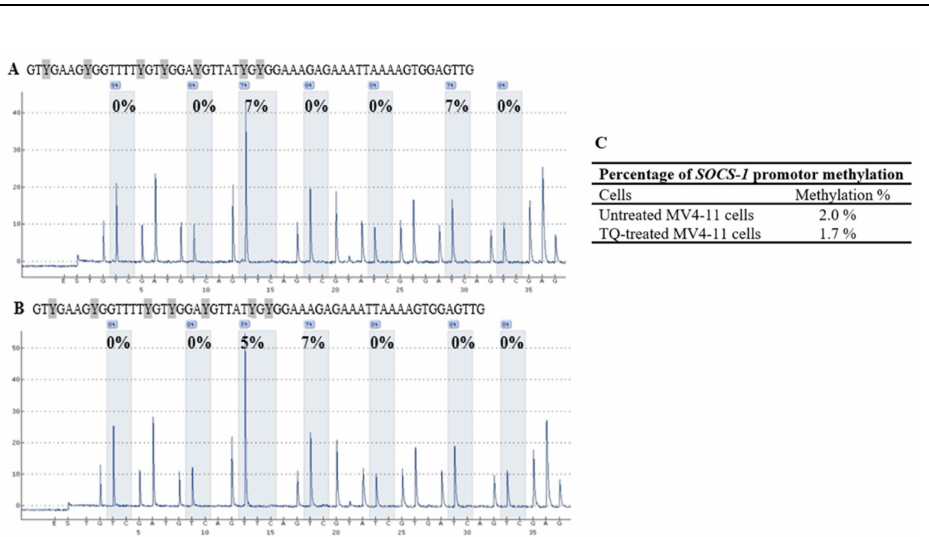
Figure 7. Pyrosequencing pyrograms for the methylation status of SOCS-1 promoter in ( A ) untreated MV4-11 cells; ( B ) TQ-treated MV4-11 cells. The percentages shown above each “C” base are the methylation level of the CpG site. The percentages shown above each “C” base are the